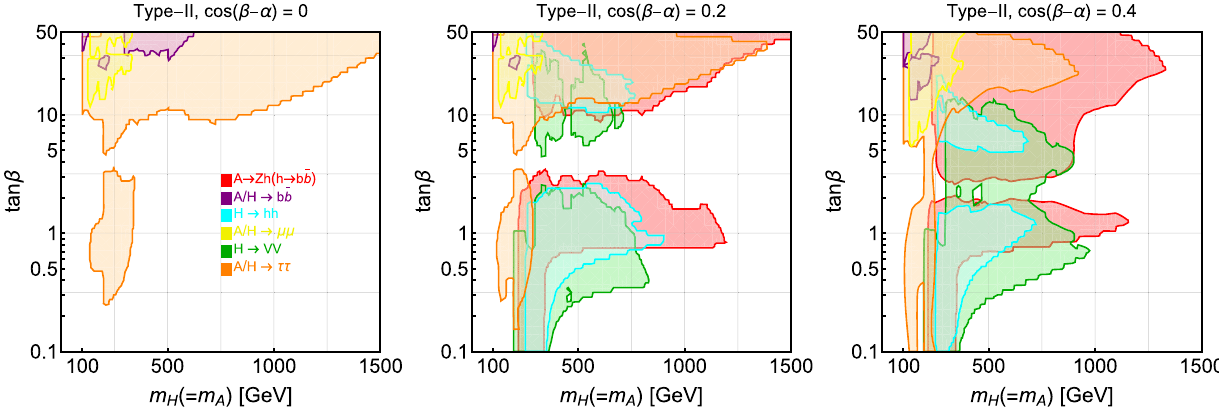
Fig. 2 Interpretation results of excluded region in the plane m H / A − tan β with latest LHC direct search limits, including A → Zh ( h → b ¯ b ) (red), A / H → b ¯ b (purple), H → hh (cyan), A / H → μ + μ − (yellow), H → V V (green), A / H → τ + τ −